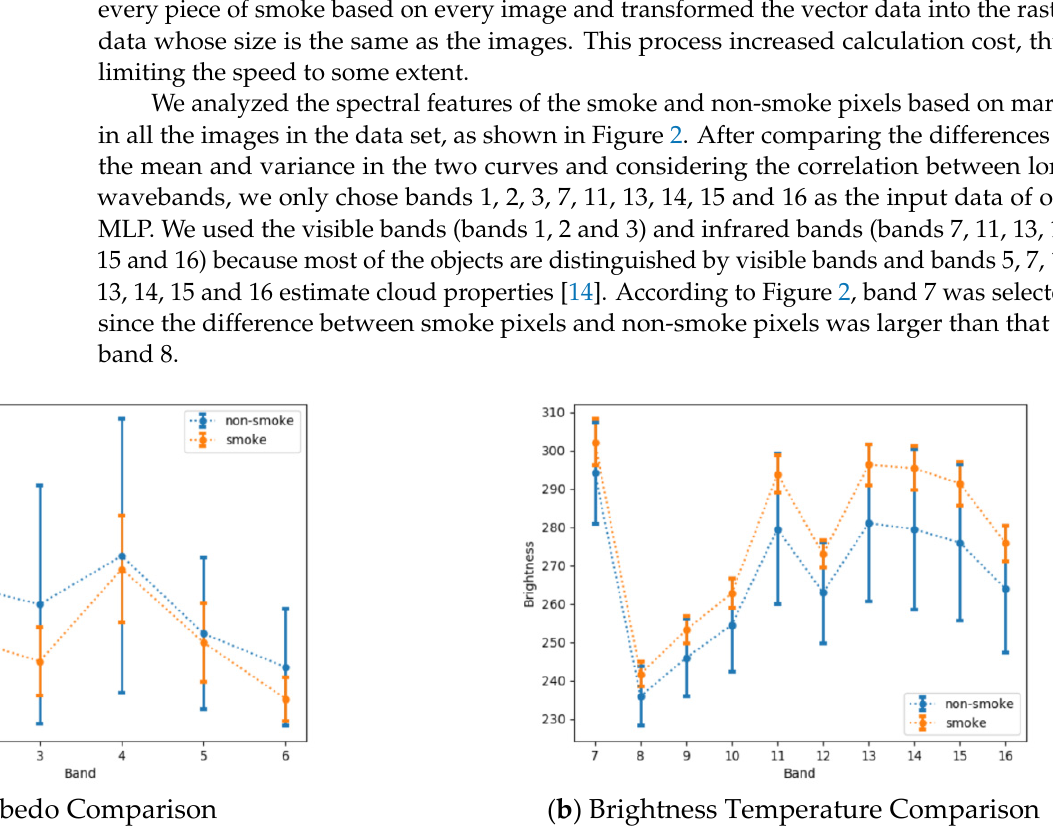
Figure 2. The statistical mean of smoke pixels and non-smoke pixels in shortwave albedo ( a ) and longwave brightness temperature ( b ). The X stick represents the bands in AHI. The units of bands 7 – 16 are K. The orange dots represent smoke pixels and blue dots represent non-smoke pixels. The error bar represents the standard deviation.